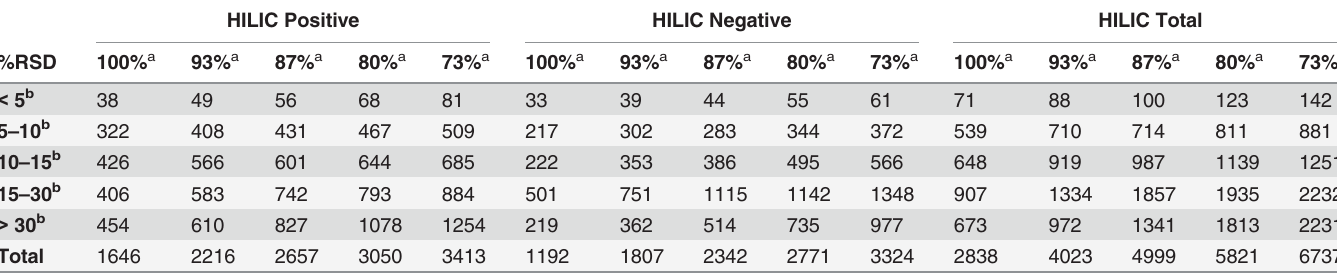
Table 3. Measured metabolite features in the HILIC method in experiment 2.